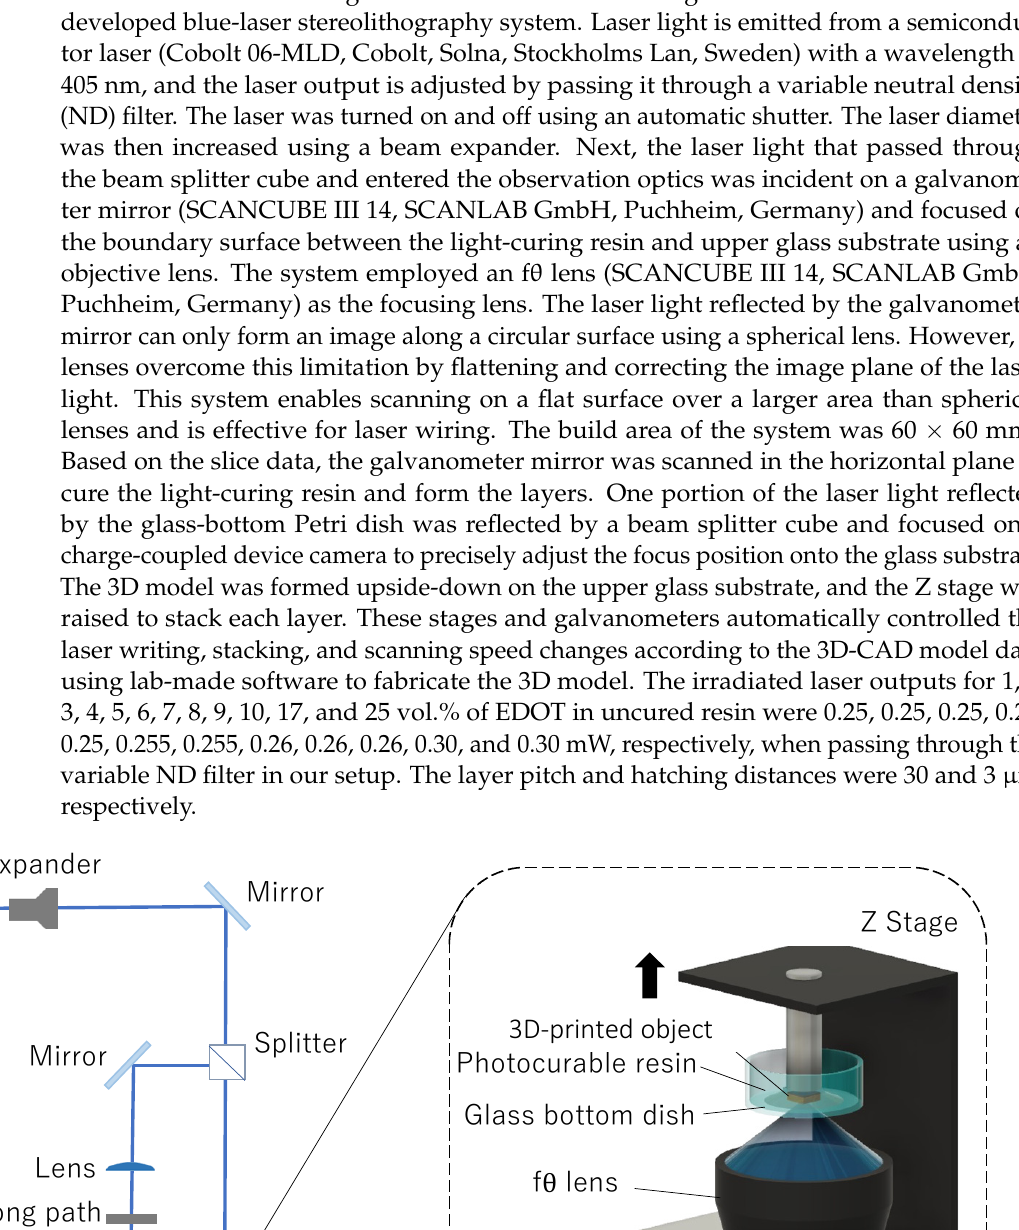
For all resins mixed with EDOT and SR252 in different volume ratios, and a TPO initiator was added at 1 wt.% to SR252. The mixture was stirred for 5